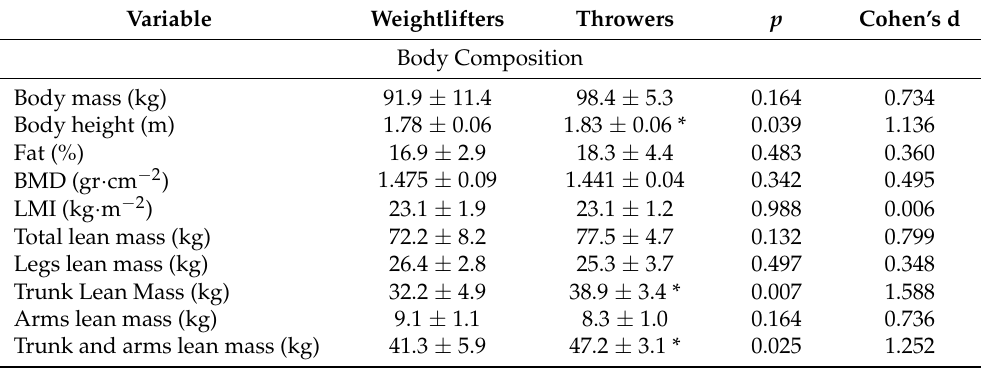
Table 1. Results of anthropometric characteristics, body composition, CMJ variables and VL muscle architecture for weightlifters and